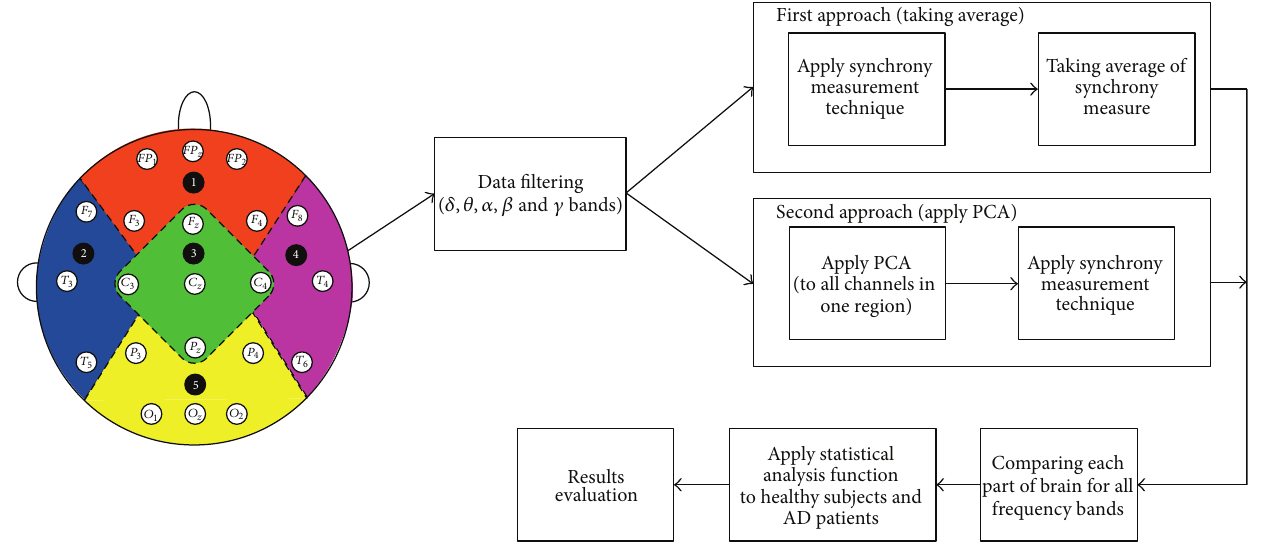
Figure 2: Average and PCA